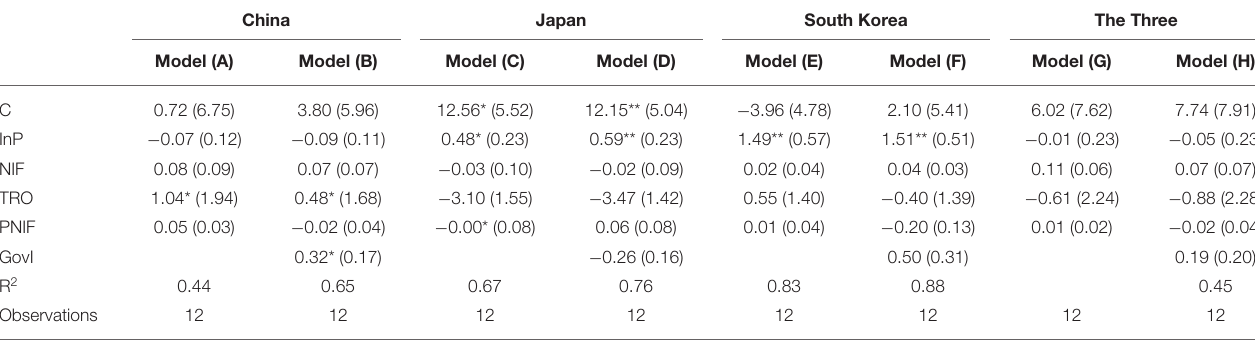
TABLE 3 | Estimated results on import.